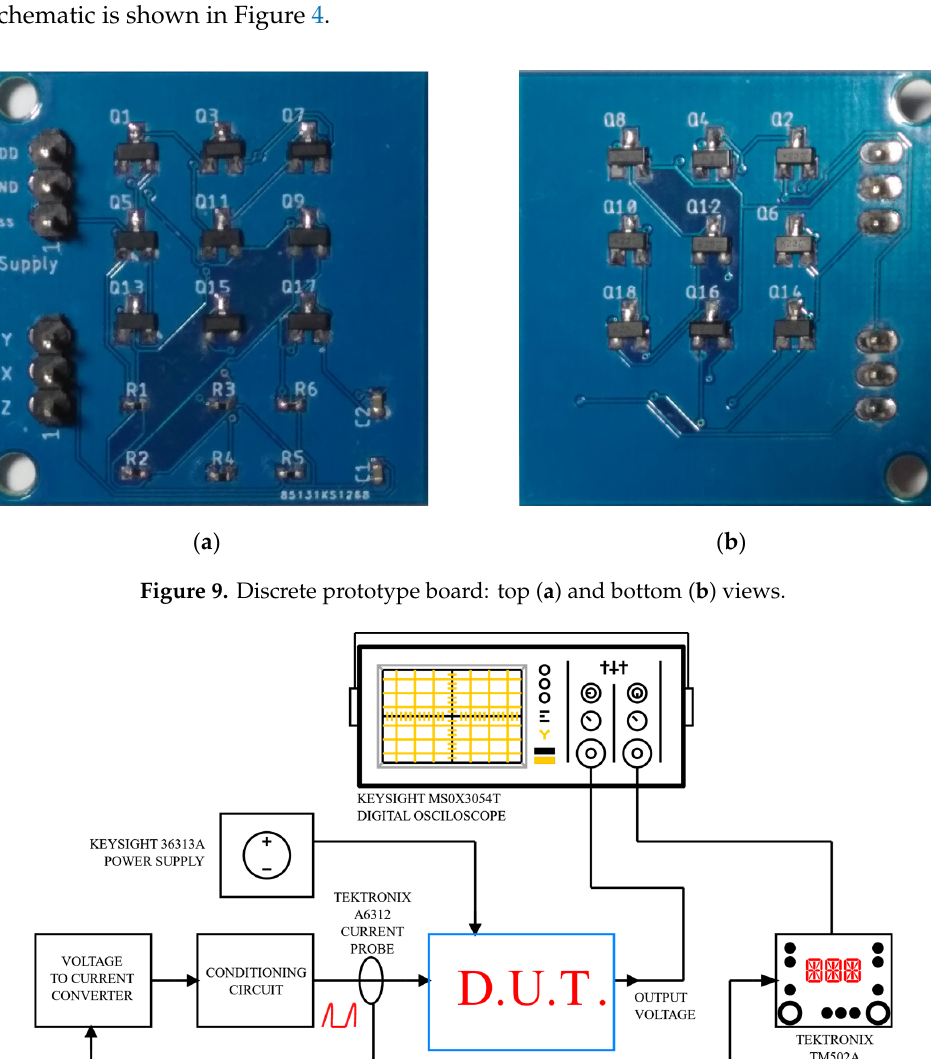
Figure 10. Test bench scheme of the prototype board.